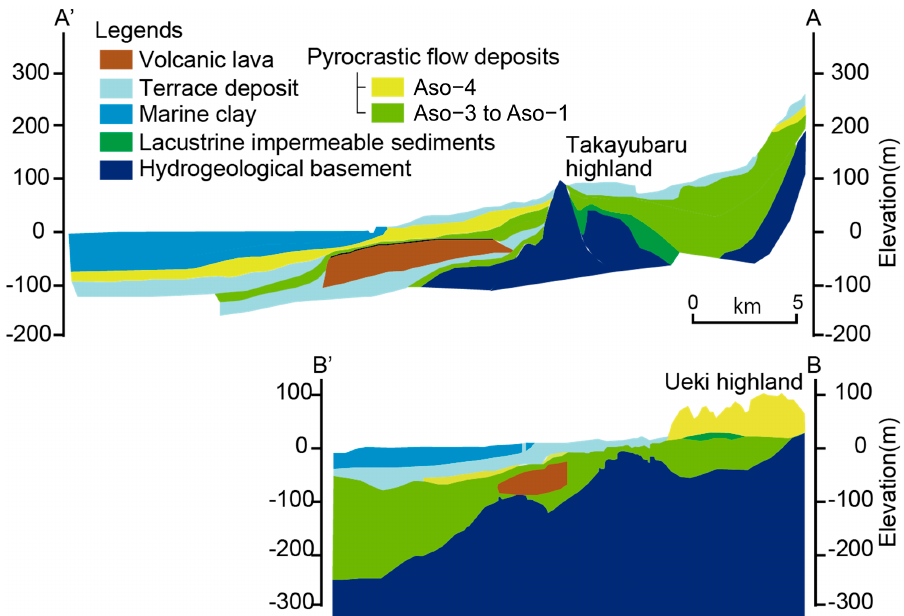
Figure 2. Subsurface cross-section of geological formations along the A − A’ and B − B’ lines in the Kumamoto area (modified after [46,52]). The location of cross-section lines is in Figure 1.